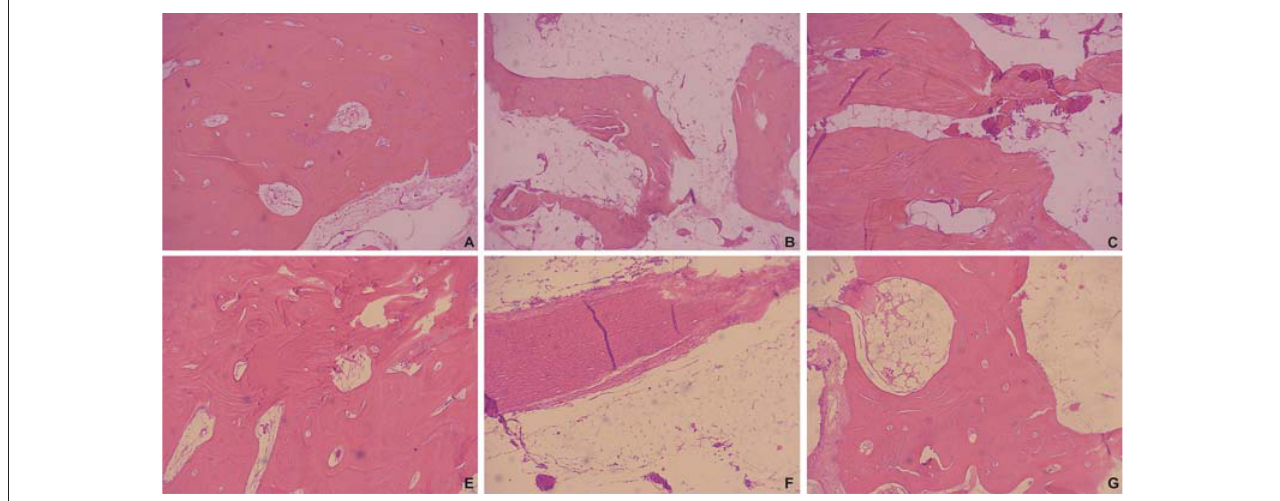
Fig. 5. Histological cuts (4´ magnification) of alveoli of mandibular premolars in beagles 90 days after extraction (hematoxylin-eosin stain): A) Bio-gen®; B) clot; C) Genox®; E) Bio-gen® + PRP; F) clot + PRP; G) Genox® + PRP.